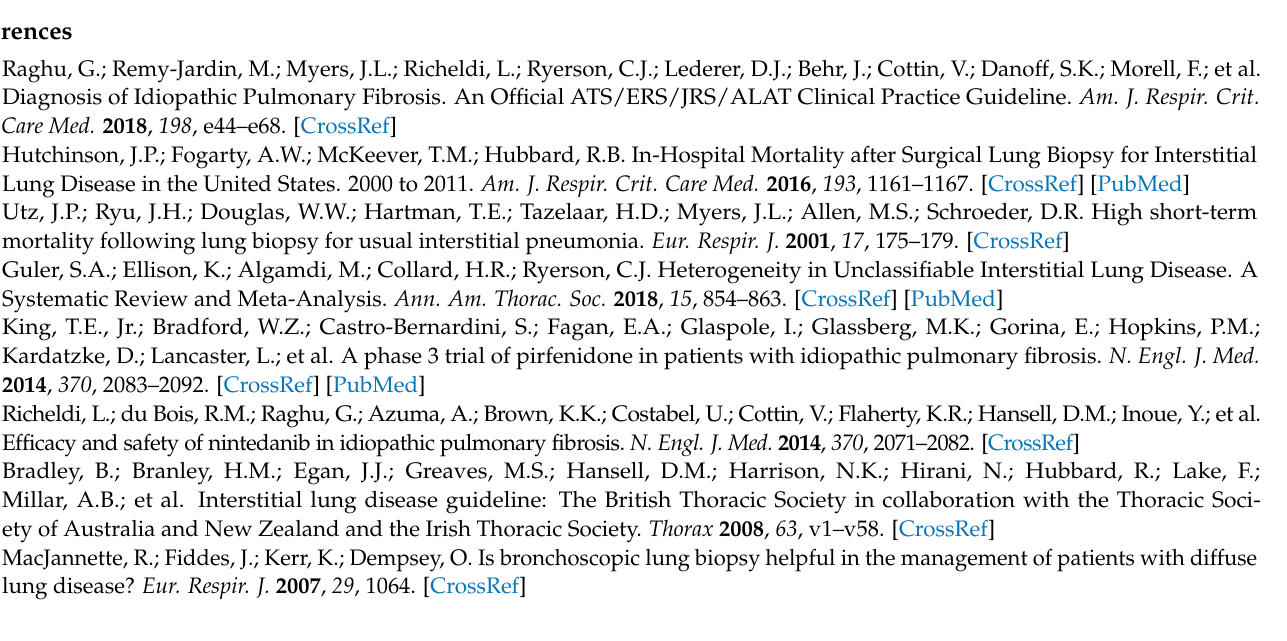
Studentized Deviance Residual by Predicted, Table S1: Whole Model Test, Table S2: Parameter Estimates, Table S3: Odds